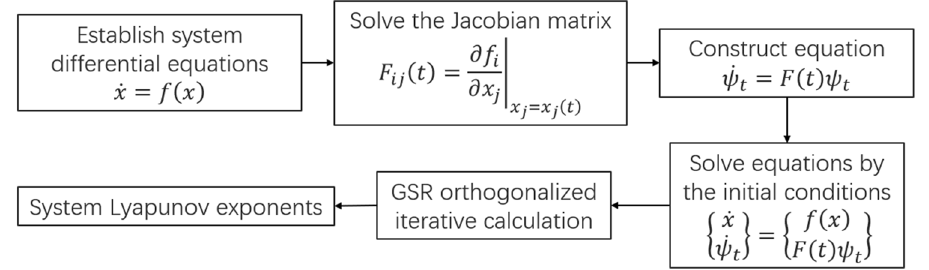
Figure 2. Calculation process of Lyapunov